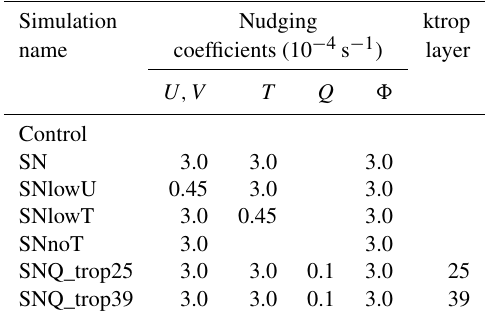
Table 1. Nudging coefficients (10 − 4 s − 1 ) used for spectral simula- tions. Spectral nudging is indicated by “SN”. U and V represent the horizontal wind component, T represents potential temperature, Q represents water vapor mixing ratio, and (cid:56) represents geopotential. Nudging is applied to all layers above the PBL. Layer 39 repre- sents approximately the mean pressure level of tropopause over the TP. Layer 25 represents approximately the normal lower limit for “ktrop” that is set to the middle layer in the model